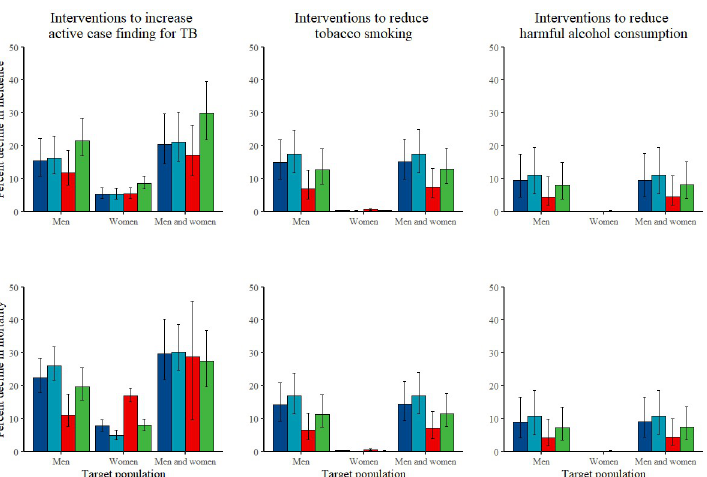
Fig 3. Percent decline in TB incidence (top) and mortality (bottom) in 2035, by target population (men, women, both men and women), for interventions to increase active case finding for TB (left), to reduce tobacco smoking (middle), and to reduce harmful alcohol consumption (right). Each plot shows median model estimates (bar) and model uncertainty (error bars) for the total population (dark blue), men (light blue), women (red), and children (green).